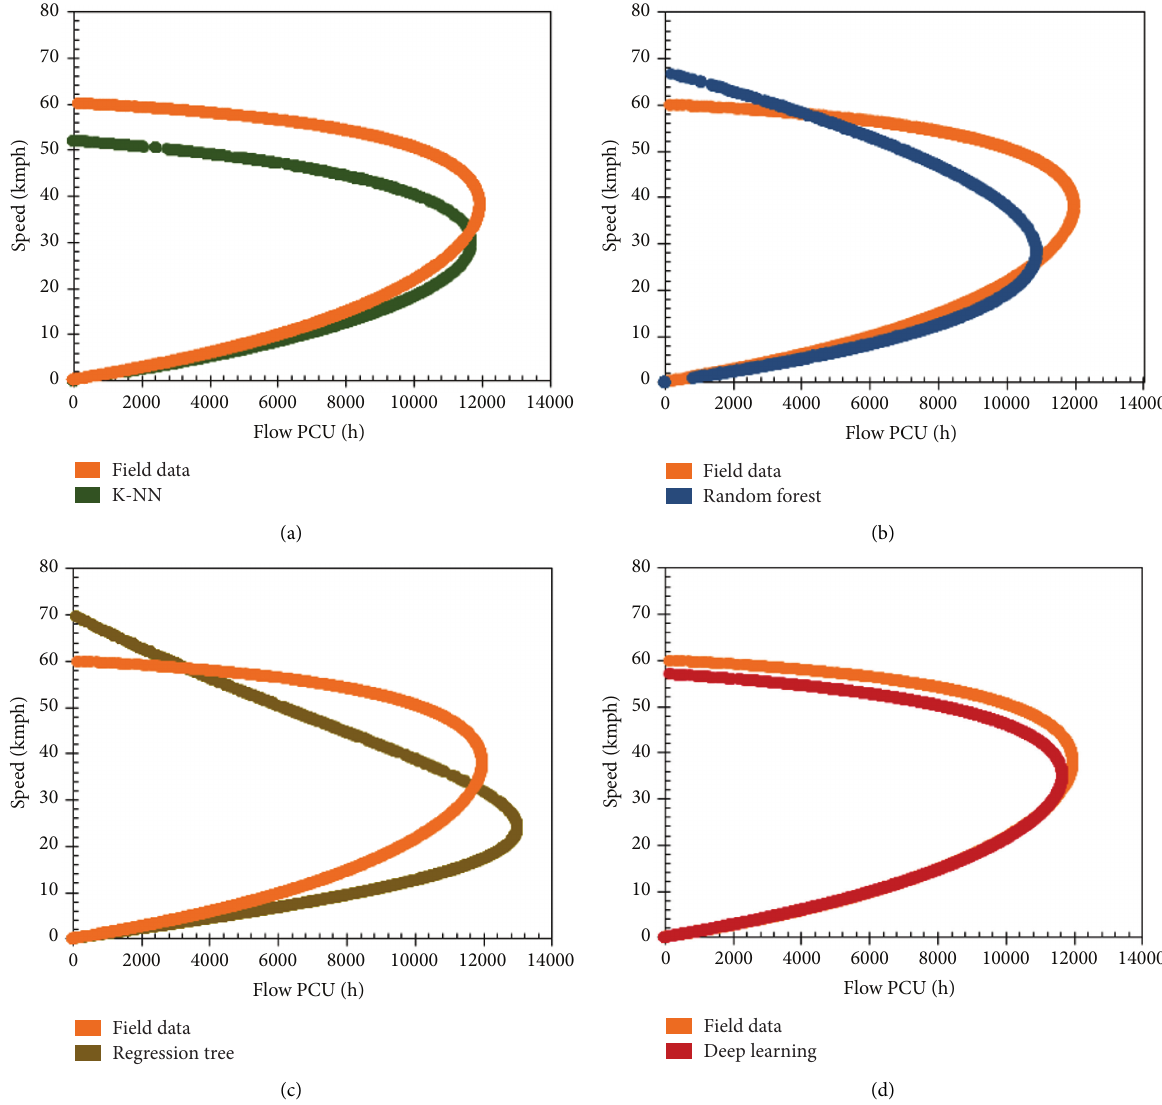
Figure 9: Macroscopic speed-flow plots from different algorithms. (a) k-NN. (b) Random forest. (c) Regression tree. (d) Deep learning. Table 6: Performance comparison of observed and predicted traffic flow measures for selected algorithms at the macroscopic level. Predicted Measure Observed k-NN Random forest Regression tree Deep learning Free-flow speed (km/h) 61 Optimum speed